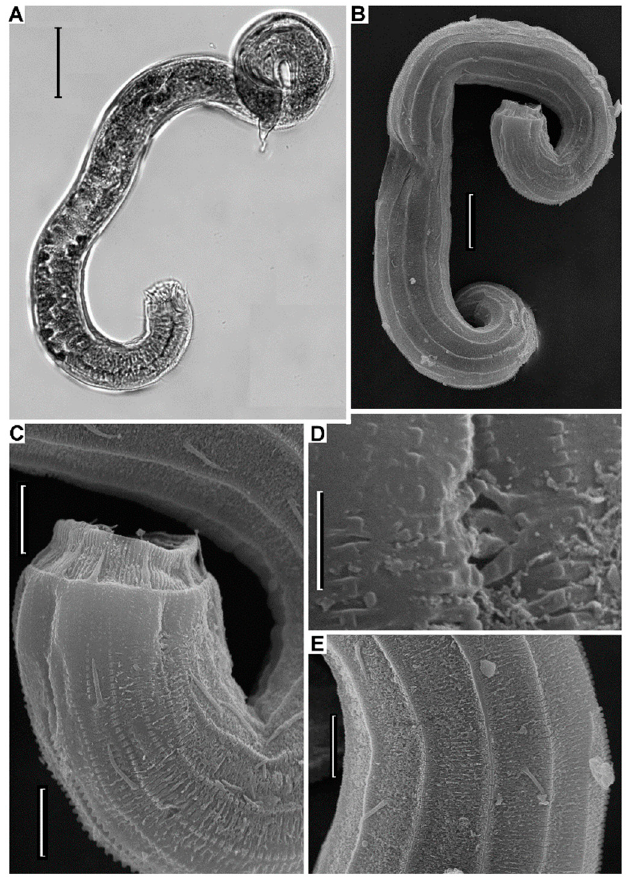
Figure 8. Latronema obscuramphis sp. n., entire body of the holotype male and surface cuticular structure: ( A ) holotype male, entire view; ( B ) entire view of a female, scanning electron micrograph; ( C ) head of a female laterally, scanning electron micrograph; ( D ) amphideal fovea of a female, scanning electron micrograph; ( E ) body cuticle rings and alae laterally, scanning electron micrograph. Scale bars: ( A ) 50 μ m, ( B ) 30 μ m, ( C , E ) 10 μ m, ( D ) 3 μ m.